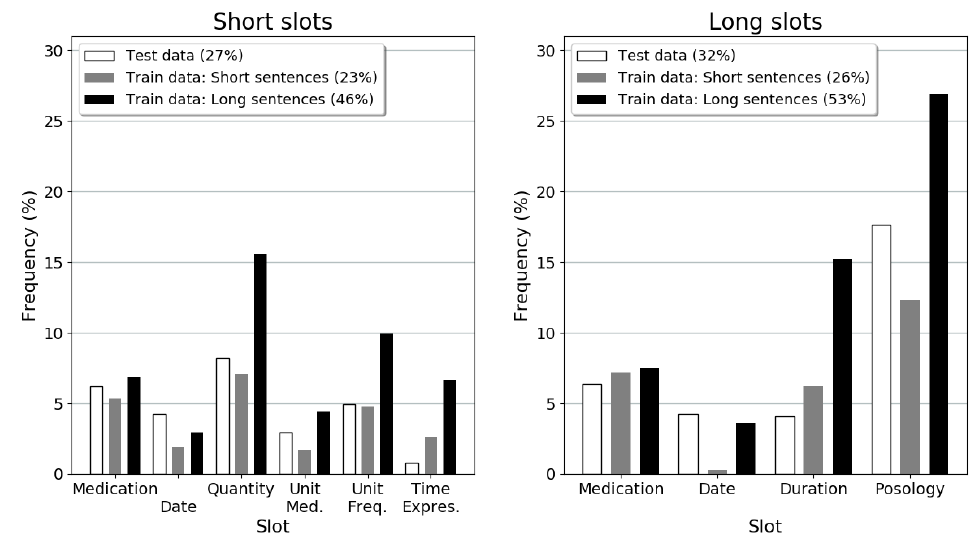
Figure 3. Composition of the datasets (short slots datasets ( left ) and long slots datasets ( right )) in terms of slot tags and tagged slot proportion (the legend percentage).